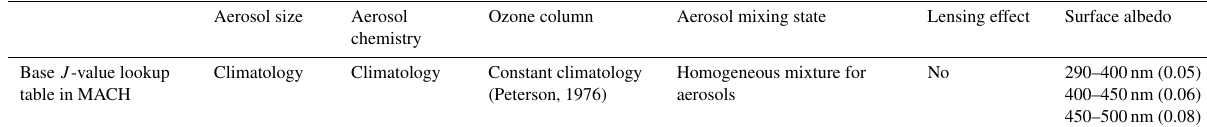
Table 1. Aerosol optical calculations in GEM and